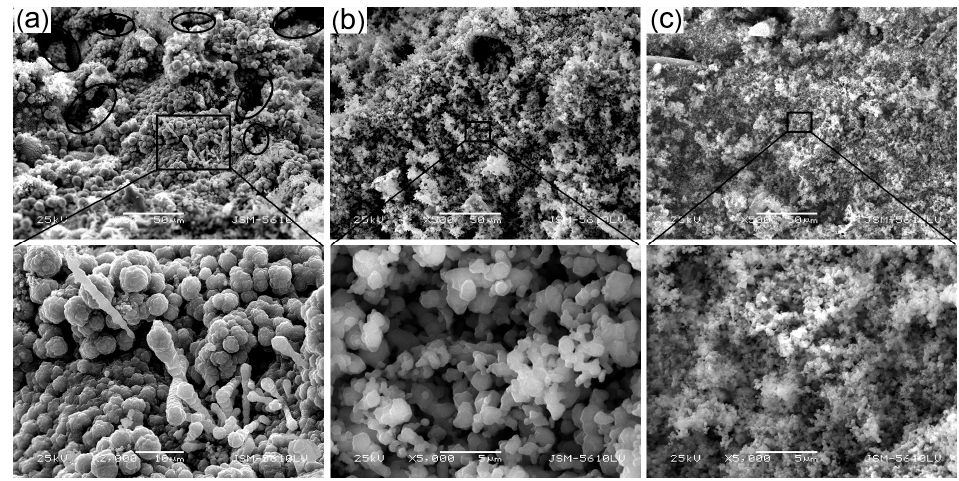
Figure 8. SEM micrographs for char surfaces of SR composites after oxyacetylene torch test: ( a ) SR00; ( b ) SR10 and; ( c ) SR16.